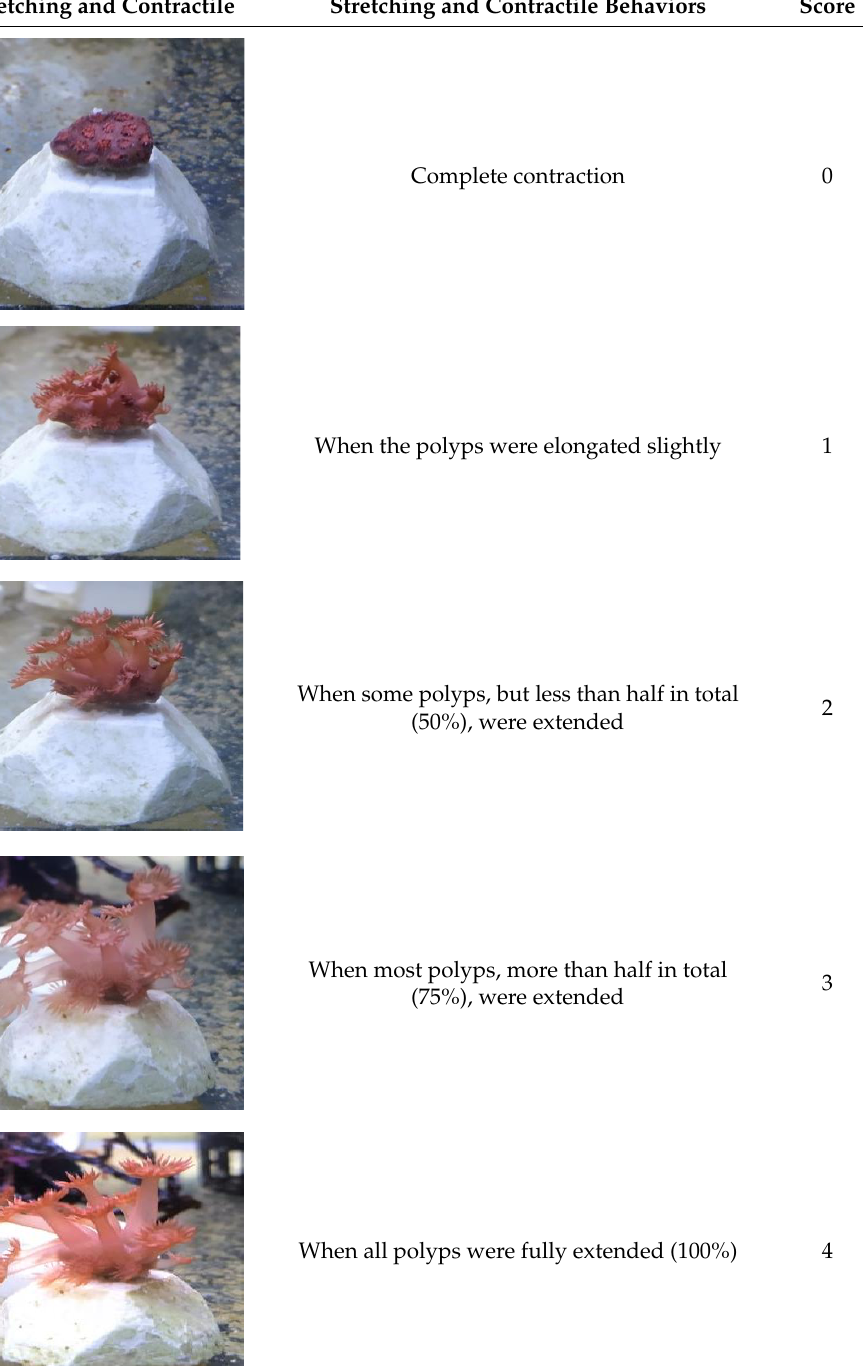
Table 3. Scores for stretching and contractile behaviors in Goniopora columna polyps.